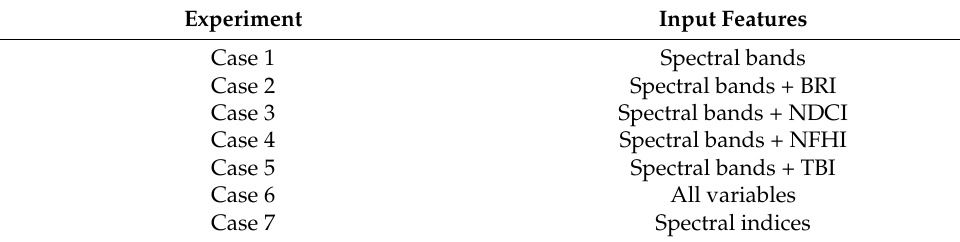
Table 3. Information on the experimental